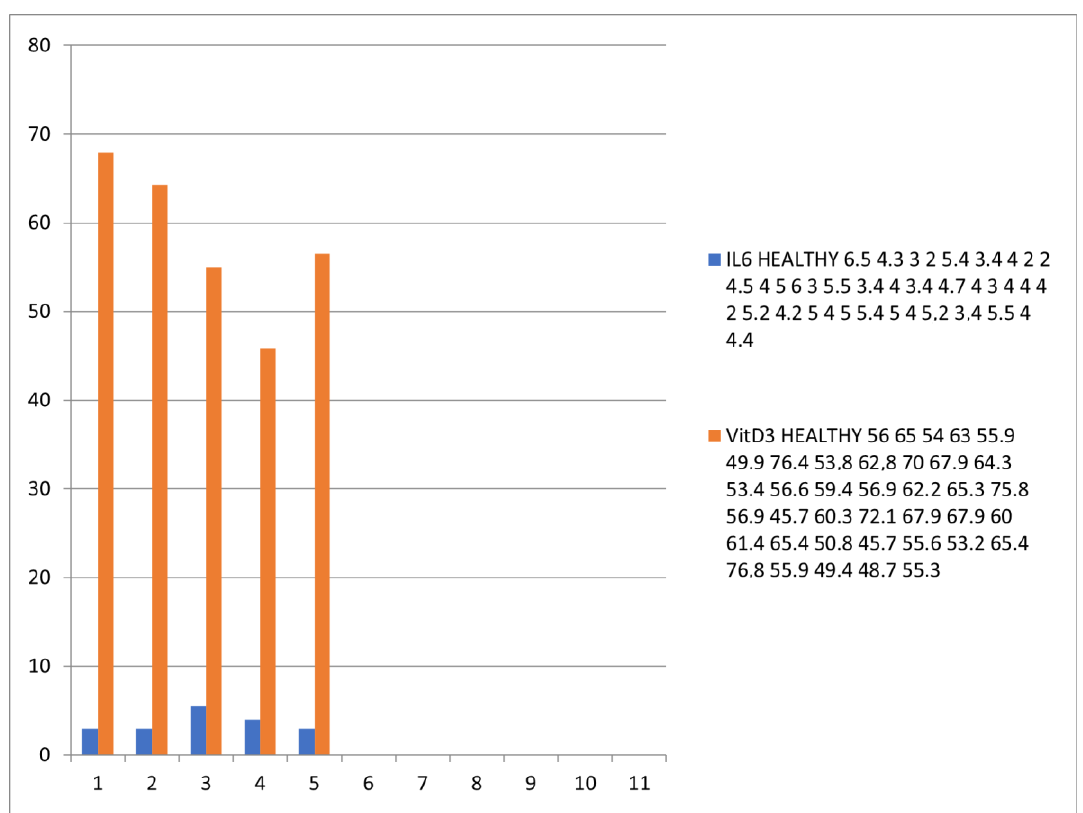
Figure 7. Graphic showing the plasma concentration of vitamin D (blue) and IL-6 (orange-red) in healthy individuals.